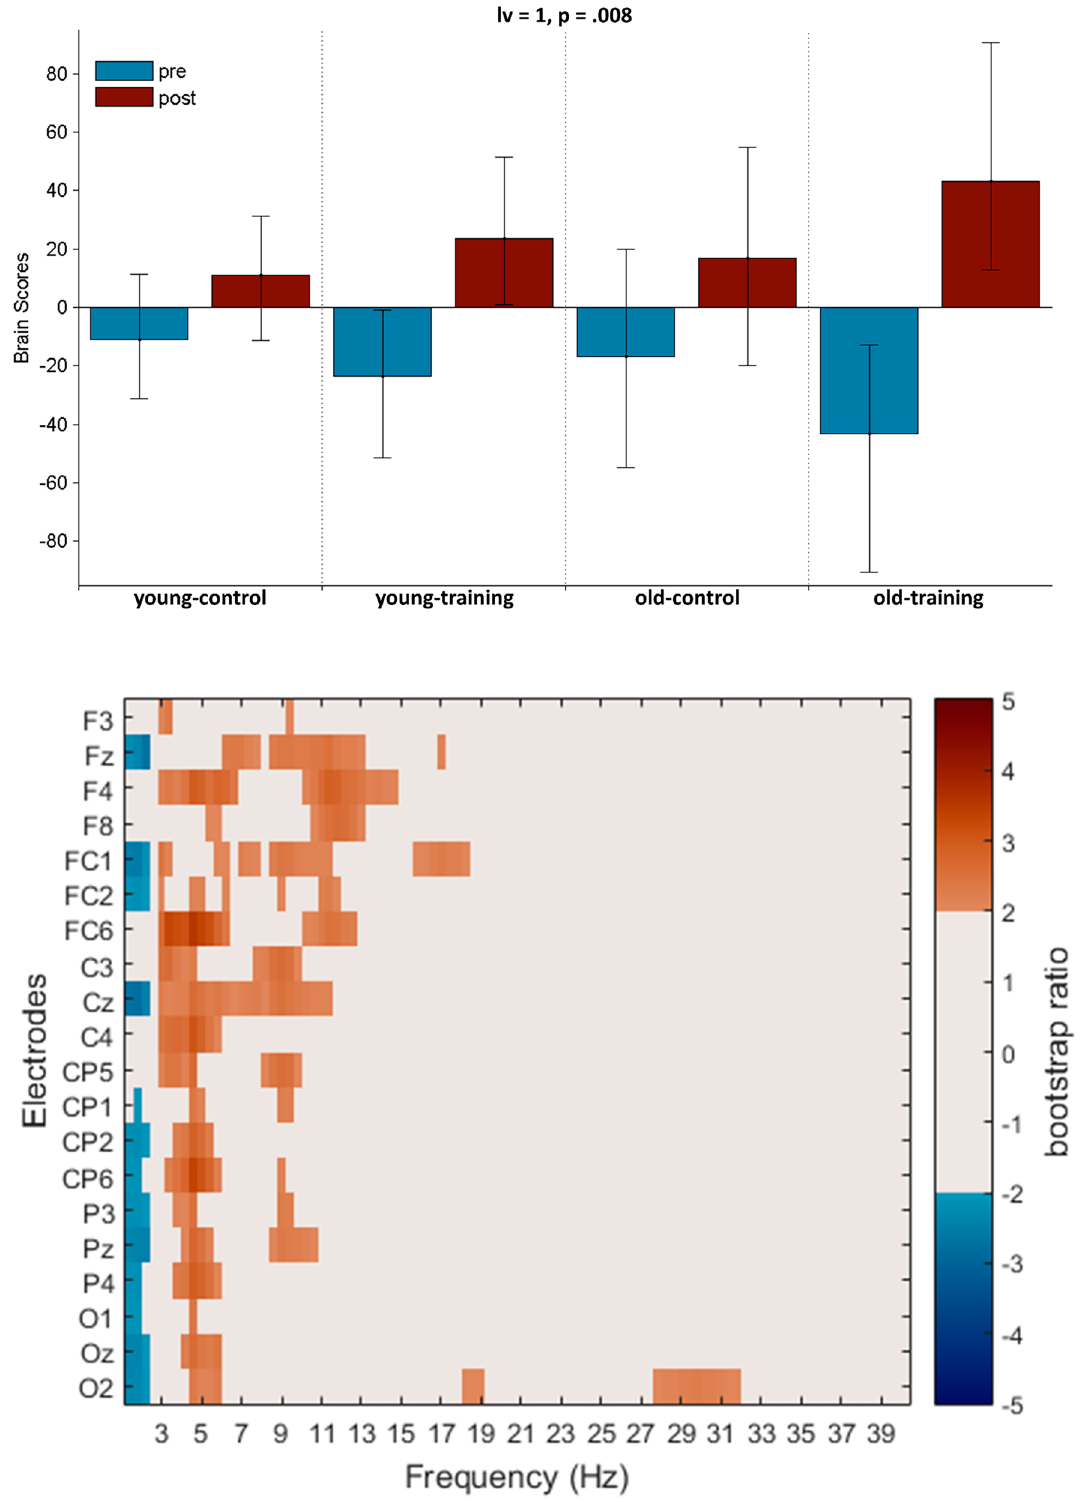
Figure 8. PLS analysis results for the group by condition effect (pre- vs. post-training resting state) on SPD. (Top) The bar graph depicts the contrast between experimental groups across age and training conditions that was significantly expressed across electrodes and frequencies as determined by permutation tests, with error bars denoting 95% confidence intervals. (Bottom) The bootstrap ratio map illustrates the electrodes and frequencies at which the contrast displayed in the bar graphs was most stable. Values represent the ratio of the individual electrode weights and the bootstrap-derived standard error (roughly z scores, thresholded at 2.0 which corresponds approximately to p < 0.05). Positive values are plotted in warm colours and indicate frequencies and electrodes showing increases from pre- to post-training in resting state SPD. Negative values are plotted in cool colours and denote decreases from pre- to post-training in resting state